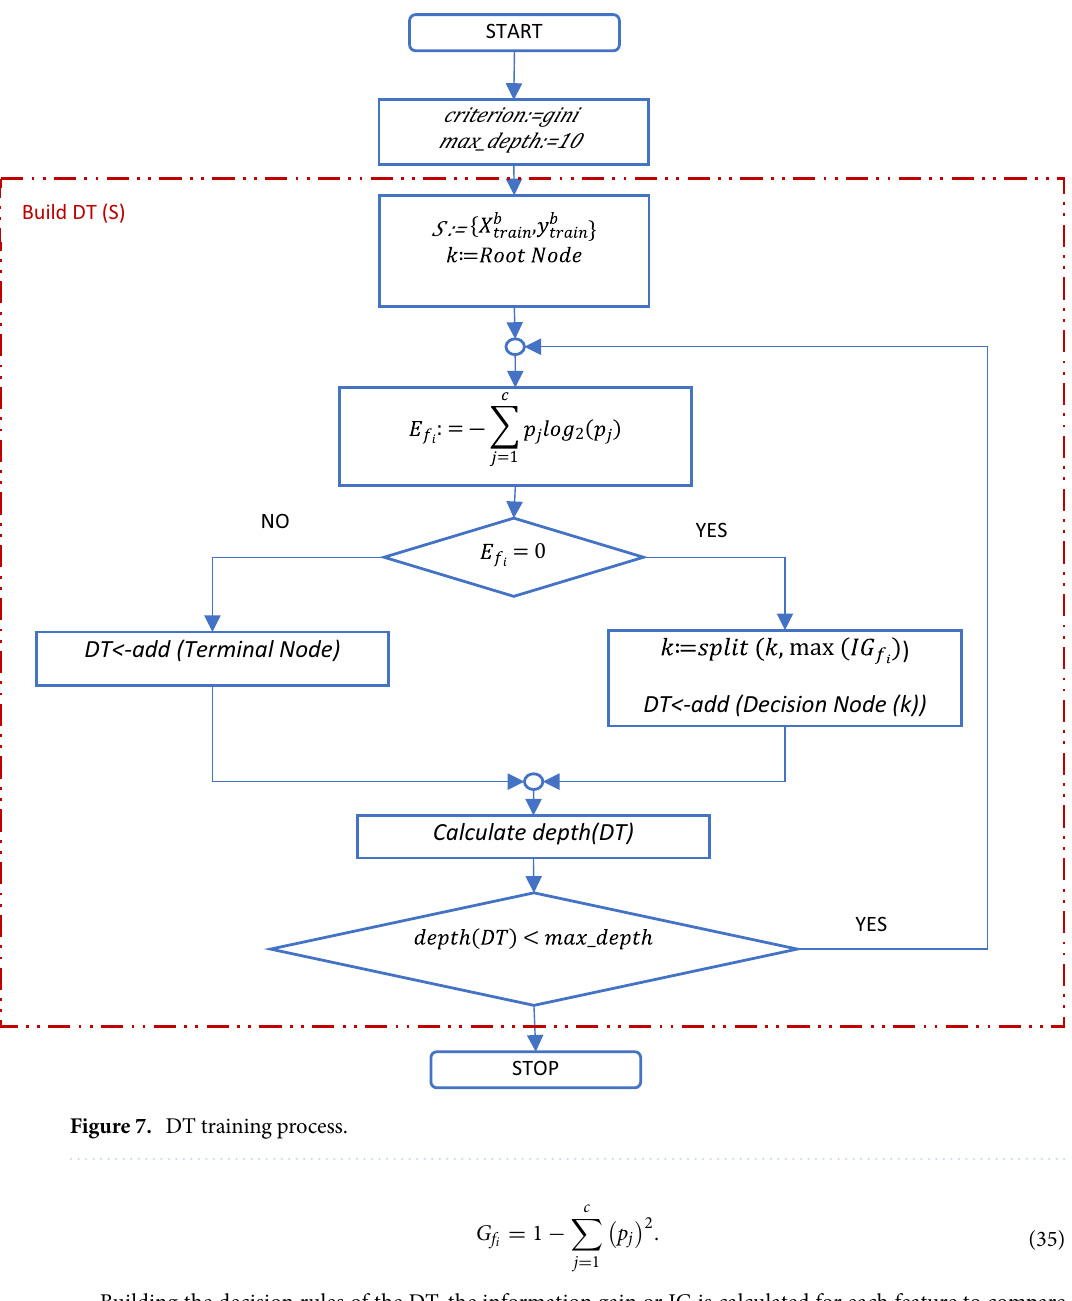
Figure 7. DT training